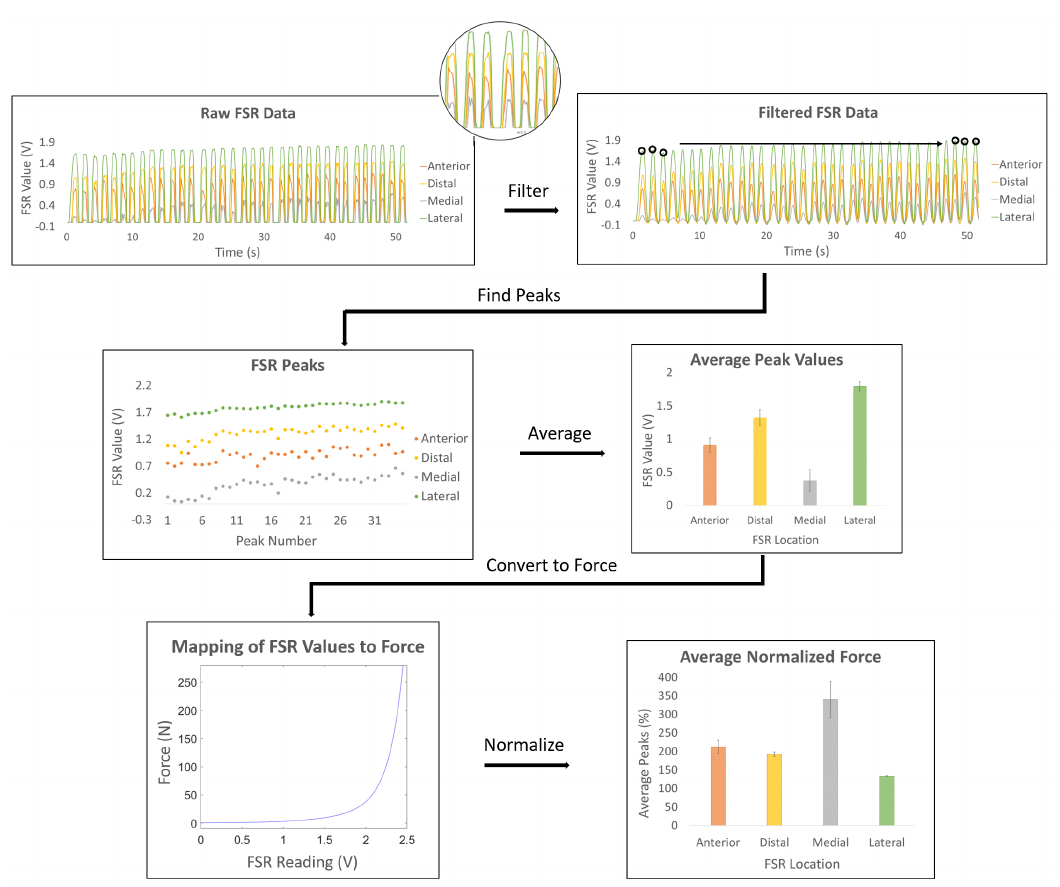
Figure 2. The data analysis process. The data analysis process consisted of filtering raw force sensitive resistor (FSR) signals, finding peaks of the filtered signals, averaging peak values, converting average values to force, and normalizing the average peaks of